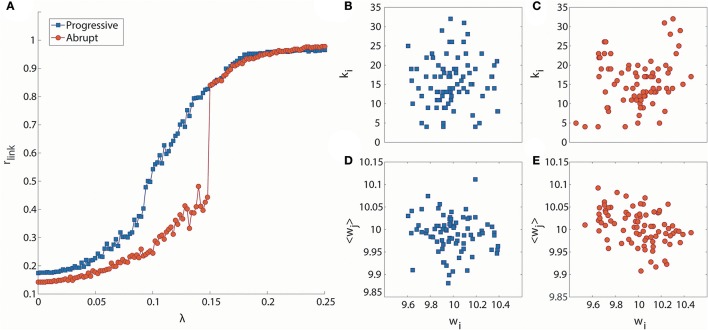
Distinct phase synchronization patterns in computational models of the human brain. (A) Exemplary cases for progressive (blue) and abrupt (red) transitions. The abrupt transition shows a sharp increase of the order parameter at λ = 0.148. The relationships between initial frequencies and node degrees for (B) progressive and (C) abrupt transitions are presented. The abrupt transition has a V-shape in the relationship. The relationships between initial frequencies and average frequencies of the nearest neighbor nodes are also presented for (D) progressive transition (ρf = −0.098) and (E) abrupt transition (ρf = −0.430).